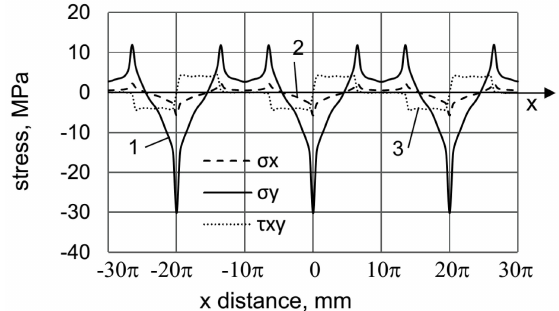
Figure 5. Stress at the upper boundary of the layer along the x axis; 1— σ y ; 2— σ x ; 3— τ xy